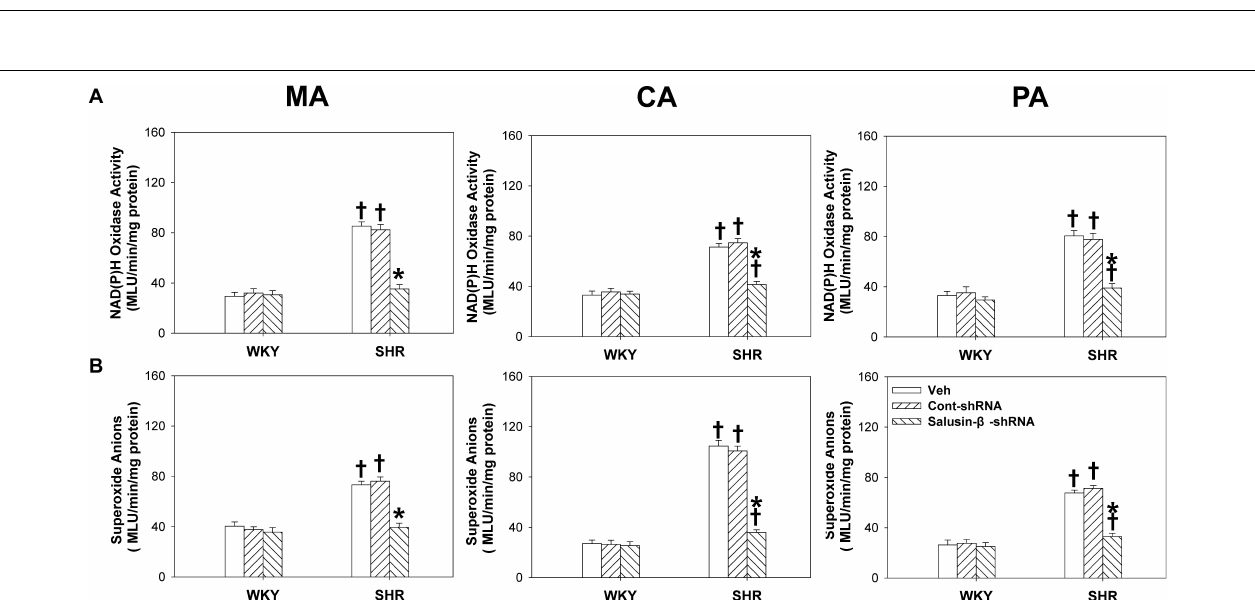
FIGURE 8 | The effects of salusin- β knockdown on NAD(P)H oxidase activity (A) and superoxide anion levels (B) of MA, CA, and PA in WKY and SHR. Two-way ANOVA was used for data analysis, followed by Bonferrioni post hoc test to compare with the multiple groups. Values are mean ± SE. ∗ P < 0.05 compared with Veh or Cont-shRNA, † P < 0.05 compared with WKY. n = 6 for each group.